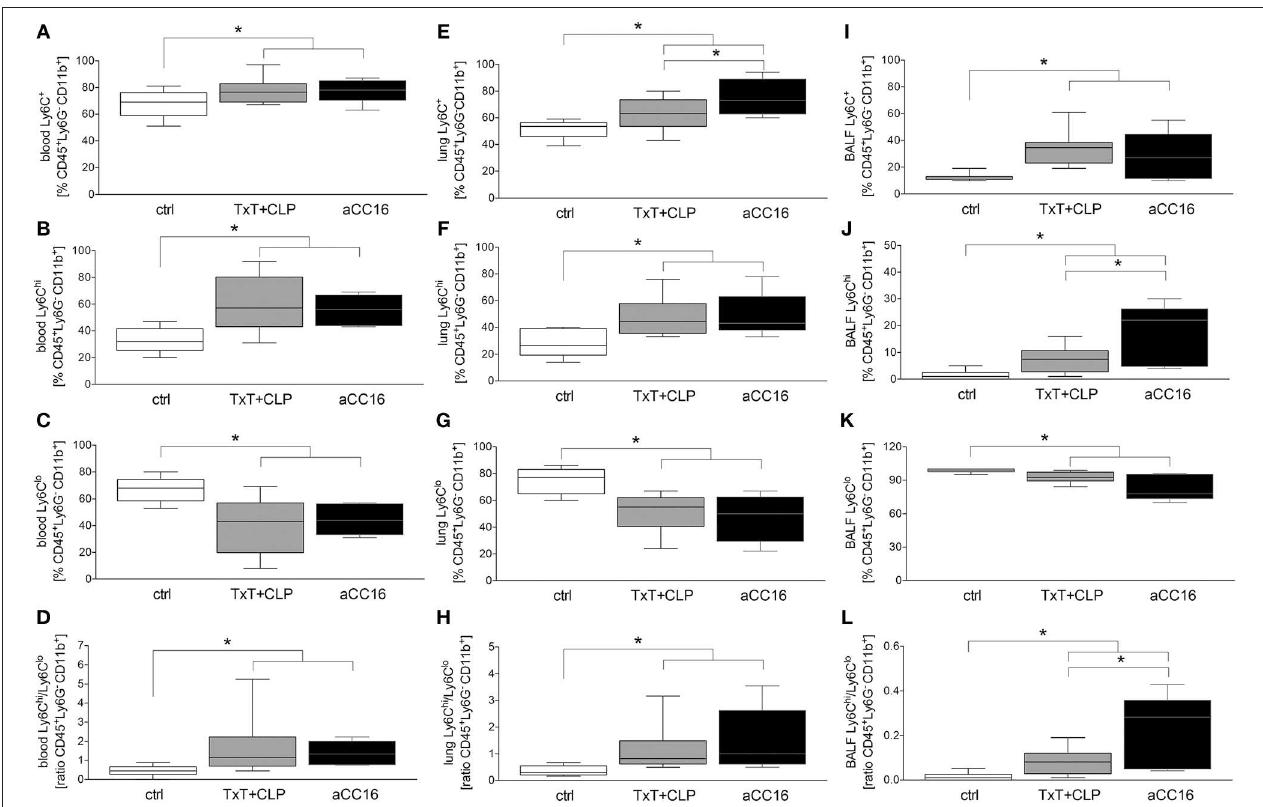
FIGURE 3 | Impact of CC16 neutralization on distribution of monocyte subsets following thoracic trauma (TxT) with cecal ligation and puncture (CLP). Activated monocyte count (Ly6C + ) as well the pro-inflammatory (Ly6C hi ) and patrolling (Ly6C lo ) subsets and the ratio between them were assessed in blood (A–D) , lungs (E–H) and BALF (I–L) by flow cytometry. Data are represented as box-whisker plot and min to max, * p < 0.05 vs.